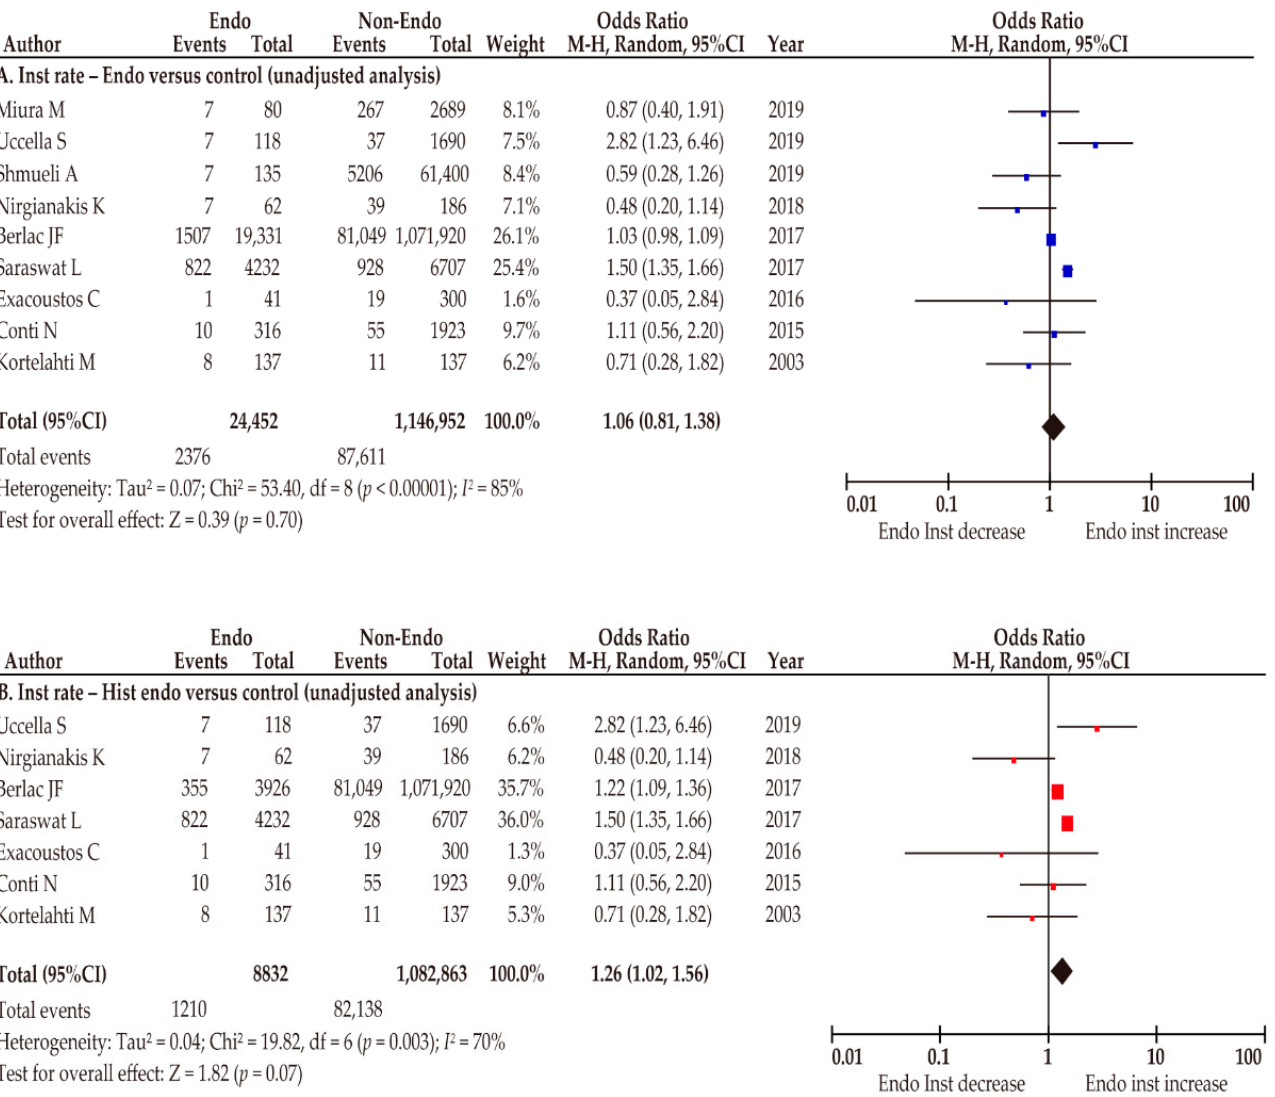
Figure 2. Meta-analysis of the effect of endometriosis on the rate of instrumental delivery. The pooled unadjusted OR for instrumental delivery ( A ) women with endometriosis vs. women without endometriosis and ( B ) women with histologically diagnosed endometriosis vs. women without endometriosis are shown. The forest plots were modified within the stratum according to year of publication and relative weight (%) of the study. Heterogeneity was substantial in both analyses (( A ), I 2 = 85%; ( B ), I 2 = 70%). Some values listed might differ slightly from the original values because the calculation was performed using Revman v5.4.1. Abbreviations: CI, confidence interval; Endo, endometriosis; Hist endo, histologically diagnosed endometriosis; Inst, instrumental delivery, OR, odds